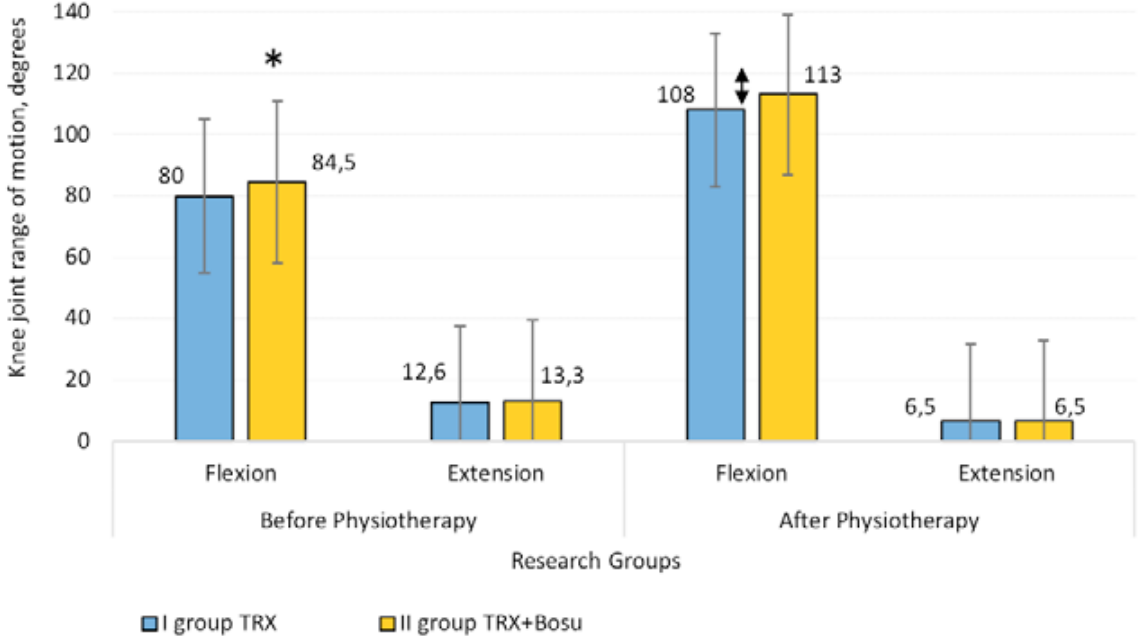
Fig. 2. Research subjects’ knee joint flexion and extension range of motion assessment. Statistical significance, p<0.05